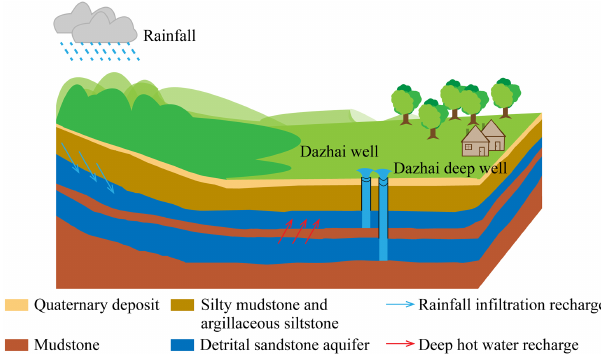
Figure 6. Conceptual model for the recharge process and hydrolog- ical coseismic response in Dazhai well.